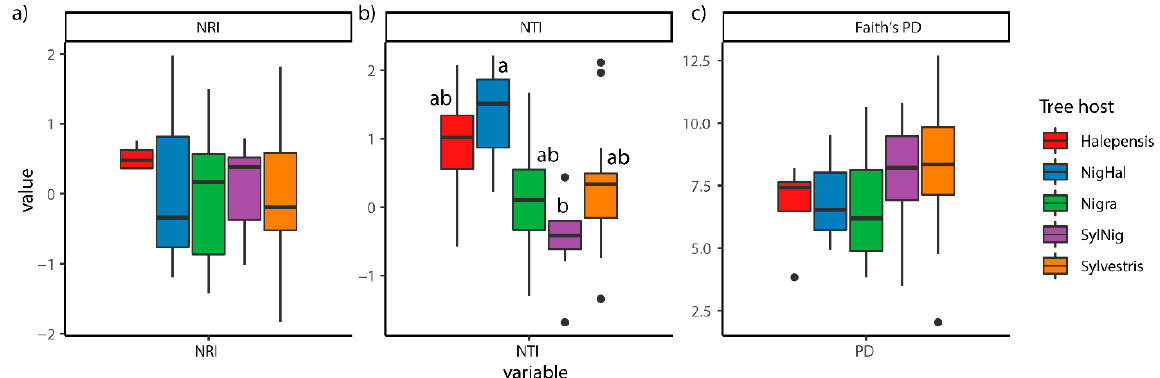
Figure 3. Boxplots displaying ( a ) Net Relatedness Index (NRI) values ( b ) Nearest Taxon Index (NTI) ( c ) Faith’s PD values between tree host species (Halepensis: P. halepensis , NigHal : P. nigra-halepensis , Nigra : P. nigra , SylNig : P. sylvestris-nigra and Sylvestris: P. sylvestris ). Means were compared using ANOVA and Tukey’s HSD tests, with letters denoting significant differences between host species.